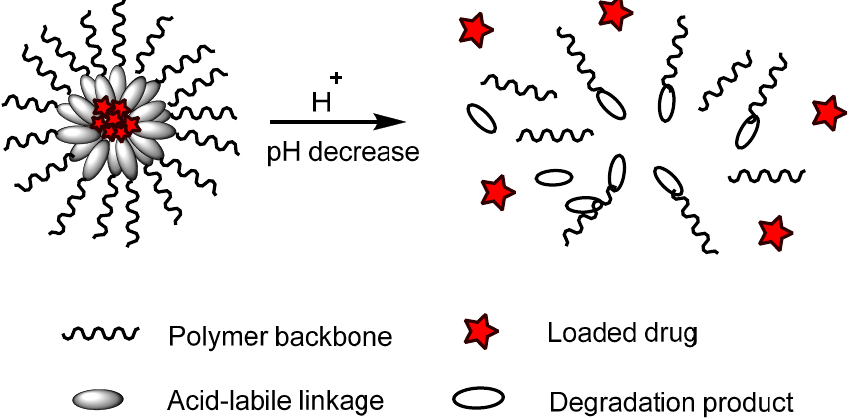
Figure 6. An example of a polymer containing an acid-labile linkage with a model drug loaded. In an acidic pH environment, the acid-labile linkage hydrolyzed and bond cleavage occurred, releasing the incorporated